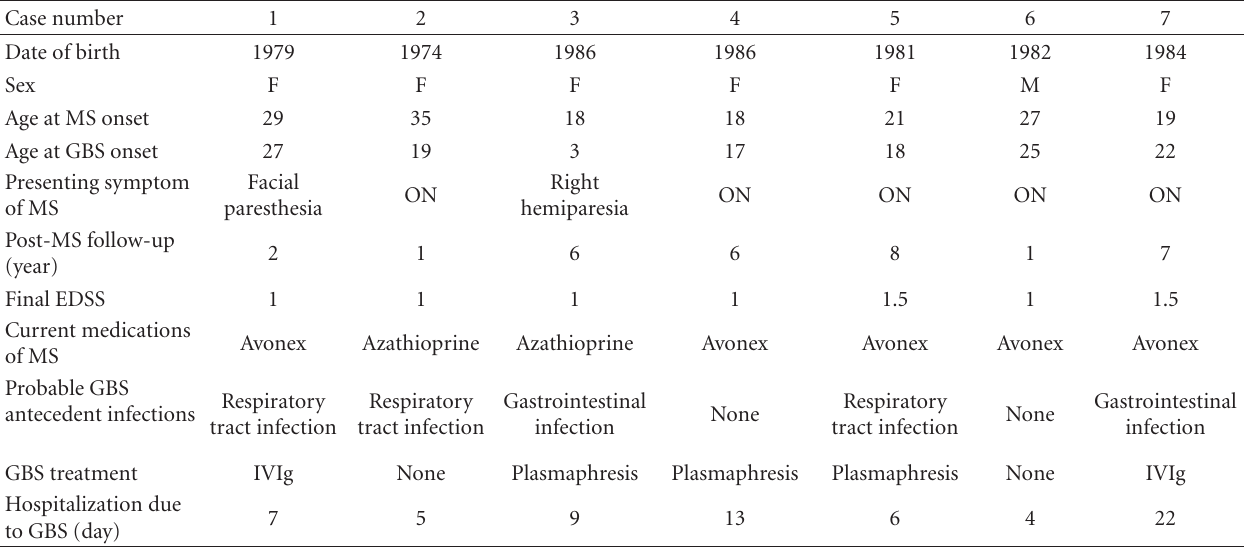
Table 1: Characteristics of seven patients with the diagnosis of both Guillain-Barre’ Syndrome and Multiple Sclerosis.